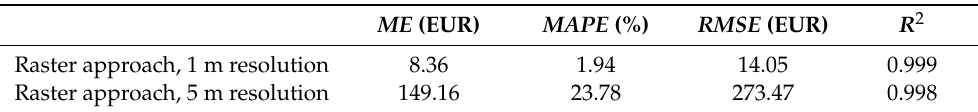
Table 10. Statistical analysis of the LATIS tool with respect to the FLIAT tool for each separate street of the road network in